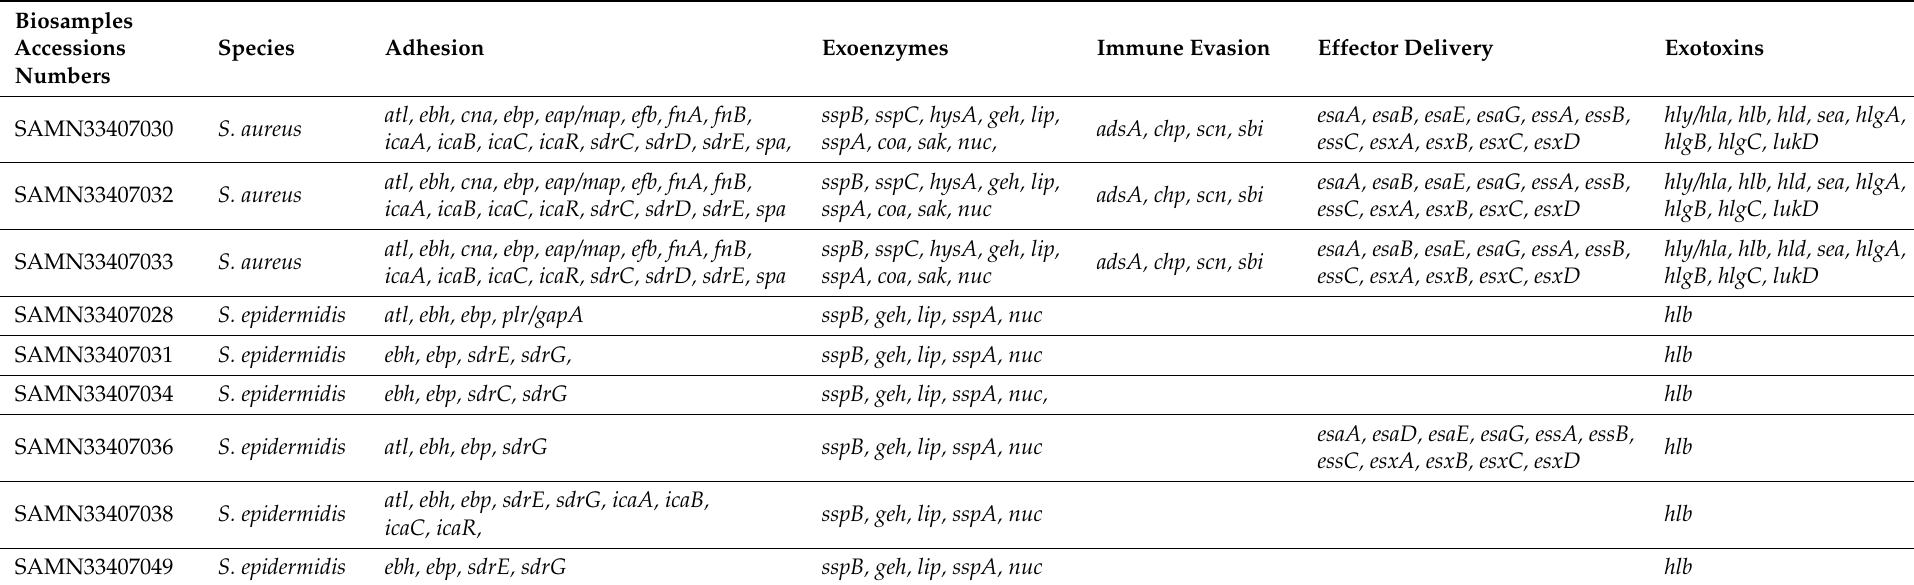
Table 3. Distribution of detected virulence factors encoding genes in MRSA and